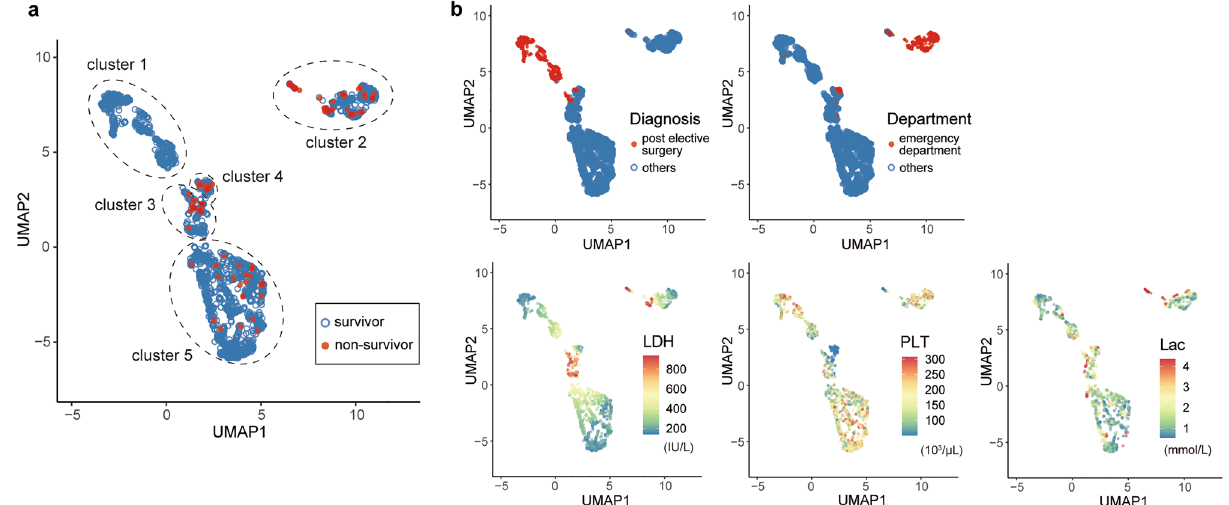
Figure 2. Clustering analysis based on mortality risk in the intensive care unit in the test cohort. ( a ) A clustering with UMAP for ICU patients was performed based on the risk of ICU mortality and the distribution of each variable. The analysis classified the patients into five clusters. ( b ) The top three variables (Lac, LDH, and PLT) contributed to predicting ICU mortality and the other two factors (Diagnosis and Department) characterized each cluster. UMAP uniform manifold approximation and projection, Lac lactate, LDH lactate dehydrogenase, PLT platelet